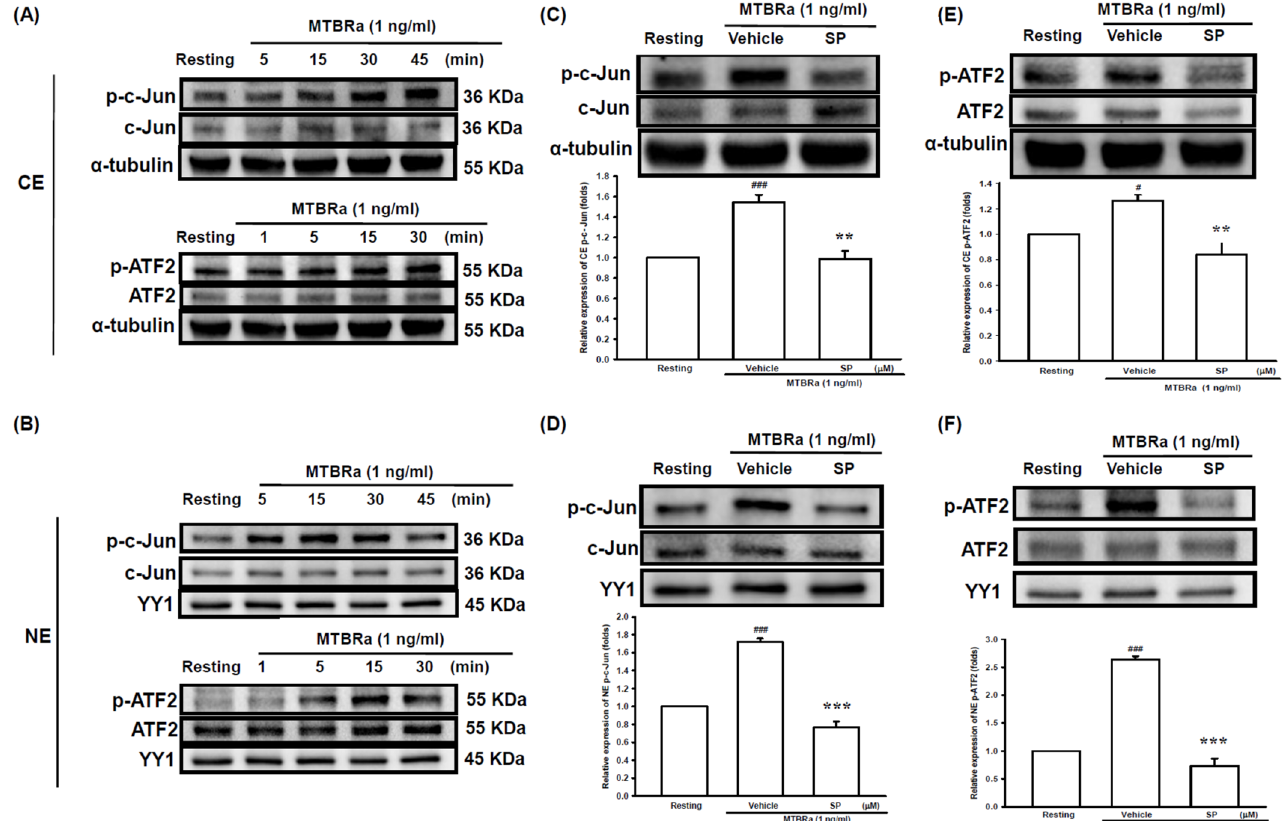
Figure 3. MTBRa activates JNK/AP-1 signaling in human PMCs. Western blotting was used to measure phosphorylated c-Jun and ATF-2 in ( A ) cytoplasmic and ( B ) nuclear extracts in MeT-5A cells treated with 1 ng/ml MTBRa for the indicated times. Western blotting was used to measure the amount of phosphorylated c-JUN in ( C ) cytoplasmic or ( D ) nuclear extract in MeT-5A cells pretreated with vehicle or SP 10 µ M followed by MTBRa treatment for 15 min. Western blotting was used to measure the amount of phosphorylated c-ATF2 in ( E ) cytoplasmic or ( F ) nuclear extract in MeT-5A cells pretreated with vehicle or SP 10 µ M followed by MTBRa treatment for 15 min. The relative folds of densitometrical data of all studies were expressed as mean ± SEM of three independent experiments. # p < 0.05, ### p < 0.001 compared with resting group; ** p < 0.01, *** p < 0.001 compared with vehicle group. MTBRa, Mycobacterium tuberculosis H37Ra; PMC, pleural mesothelial cell; SP, SP600125; CE, cytoplasmic extract; NE, nuclear extract.